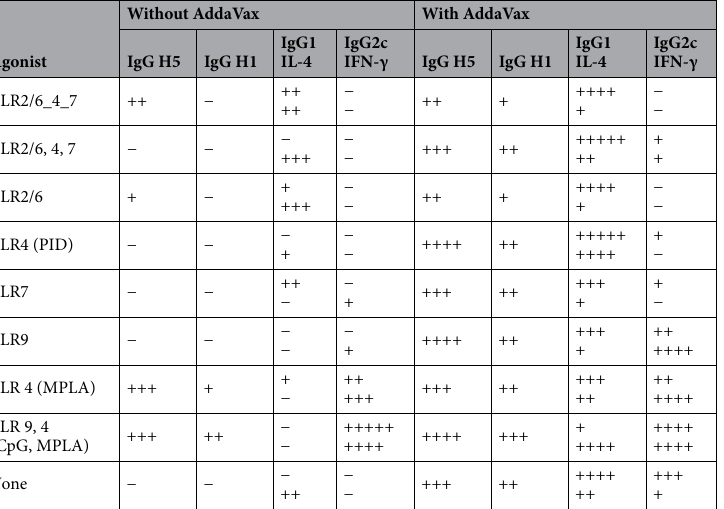
Table 3. Summary of the effect of different adjuvants on homo- (H5) and hetero- (H1) subtypic cross- reactivity and polarization of the Th1 vs Th2 response. Data for homo- and heterosubtypic cross-reactivity from Fig. 1, data for Th1 and Th2 response from Fig. 3. Key: For IgG, IgG1 and IgG2c, median signal intensities −, < 2000; +, 2000–9999; ++, 10,000–19,999; +++, 20,000–29,999; ++++, 30,000–39,999; +++++, > 40,000. For numbers of IL-4 and IFN-γ spot forming cells (SFCs) per 5 × 10 5 splenocytes: −, < 10; +, 10–24; ++, 25–49; +++, 50–75; ++++, >